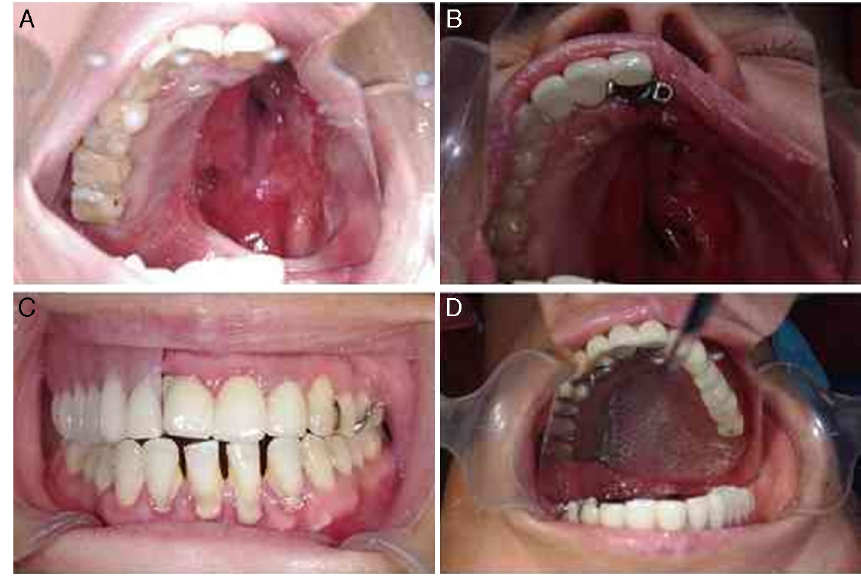
(A) Image before definite rehabilitation; (B) view of try-in of the fixed part; (C and D) view of the definite prosthesis with stud